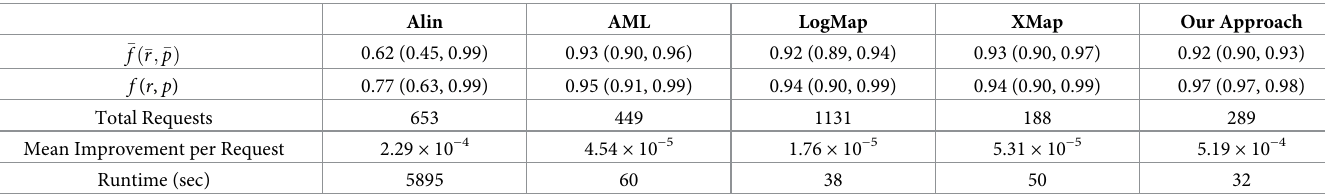
Table 2. Comparison between OAEI 2016’s participants and our approach on the interactive Large Biomedic track: FMA-NCI. Alin